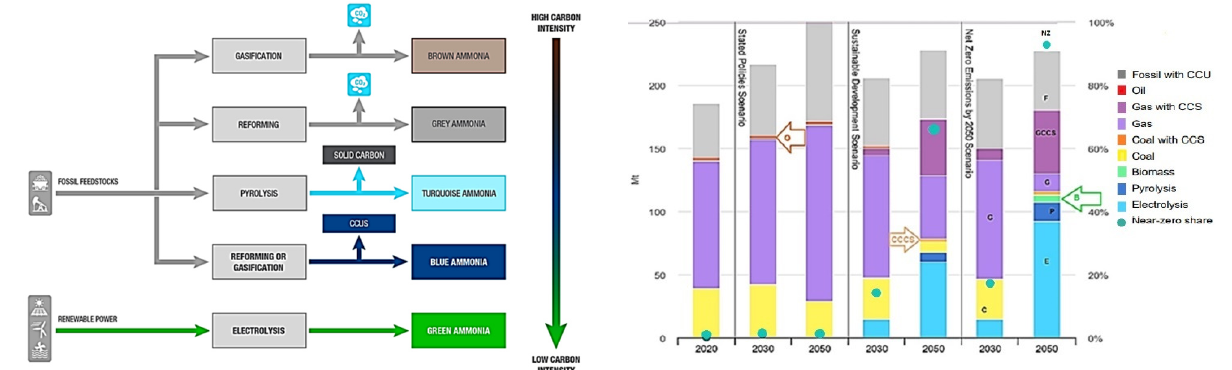
Figure 11. The pathways and technology roadmap of ammonia production in different scenarios (the stated policies, the sustainable development, and the Net Zero emissions) from 2020 to 2050 (electrolysis pyrolysis, biomass, coal, coal with CCS, gas, gas with CCS, oil, fossil with CCU methods and near-zero emission). Reprinted with permission [70,71].